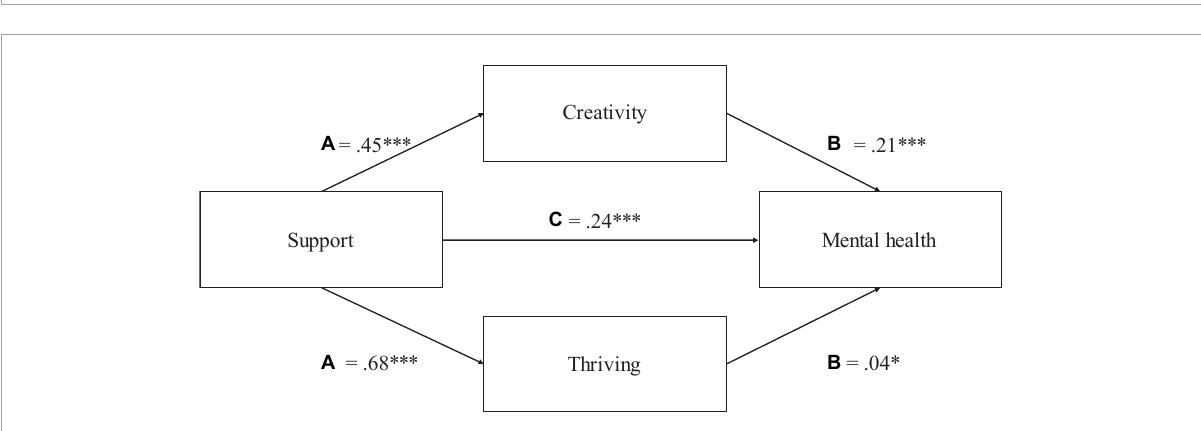
FIGURE3 The regression coefficients for path (A,B) were significant, representing effects of support on creativity and thriving, and effects of creativity and thriving on mental health. The regression coefficient for path C was also significant. * meaning significance level as follow: * p < 0.05, *** p <